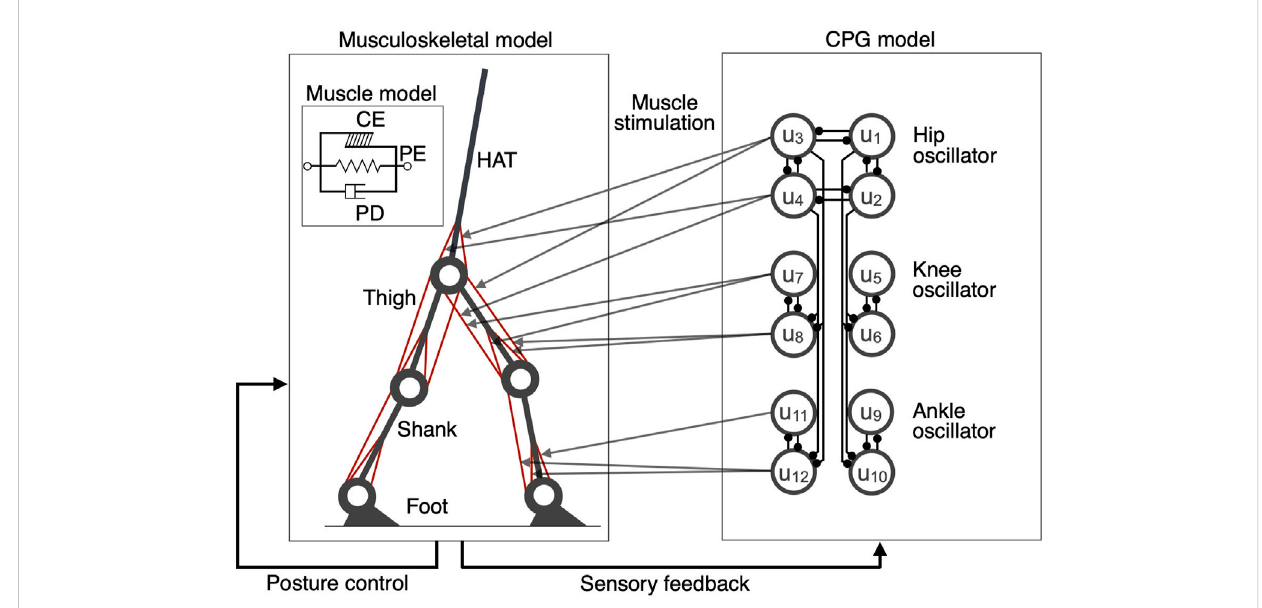
FIGURE 1 A schematic representation of the neuromusculoskeletal model. Left panel: The skeletal model consists of seven links representing the HAT (head, arms, and torso), thighs, shanks, and feet. The muscle models include (1) gluteus maximus (GM), (2) iliopsoas (IL), (3) biceps femoris long head (BFL), (4) rectus femoris (RF), (5) biceps femoris short head (BFS), (6) vastus (VA), (7) gastrocnemius (GC), (8) soleus (SO), and (9) tibialis anterior (TA). The muscle model includes contractile (CE), passive elastic (PE), and passive damping (PD) elements, respectively. Right panel: The CPG model consists of 12 internal units ( u 1 , ... , u 12 ), generating a hip oscillator, a knee oscillator, and an ankle oscillator. The output of the CPG model corresponds to each muscle